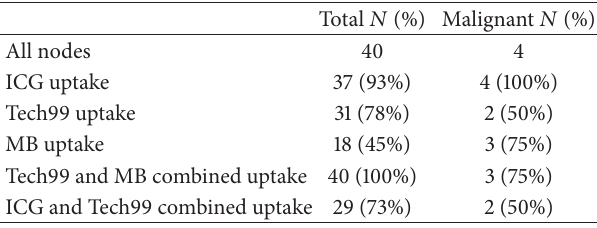
Table 2: Number of lymph nodes identified by each method.